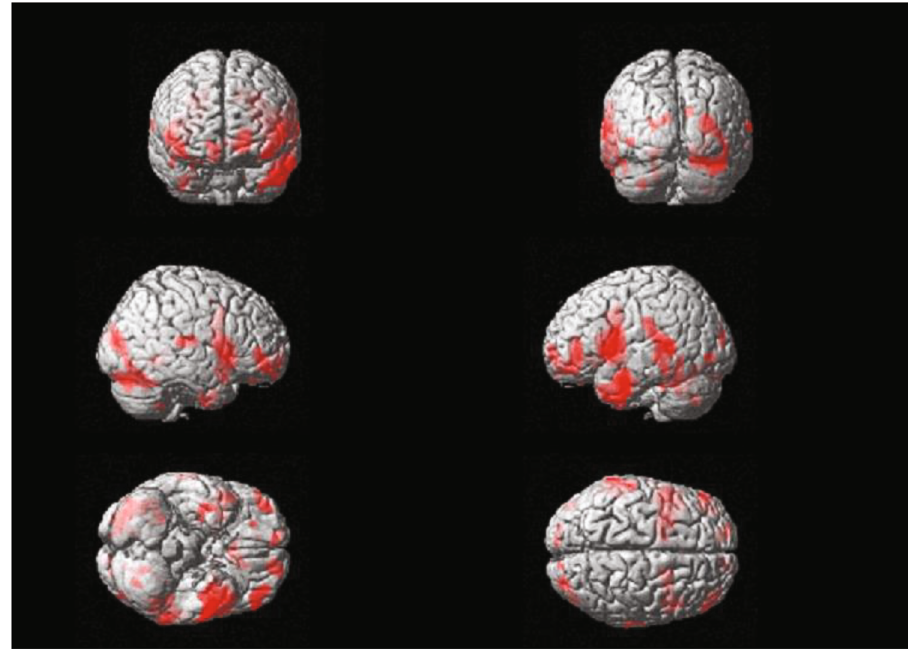
Figure 5: Brain activation image of clenching task at reevaluation